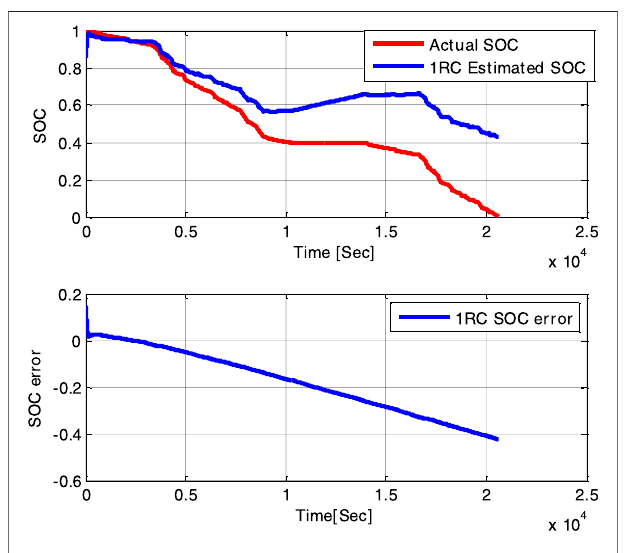
FIGURE 12 | Normal ECM based AEKF_1RC with 5% bias noise.